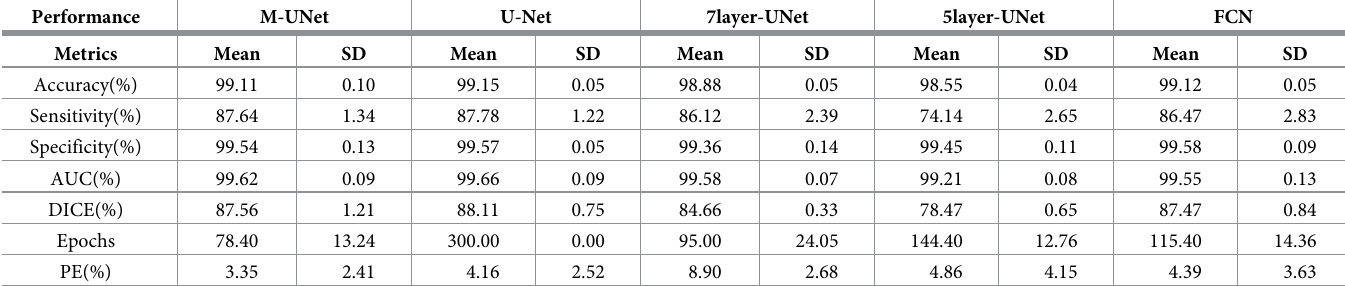
Table 4. Cell segmentation results on the first testing region for specimen